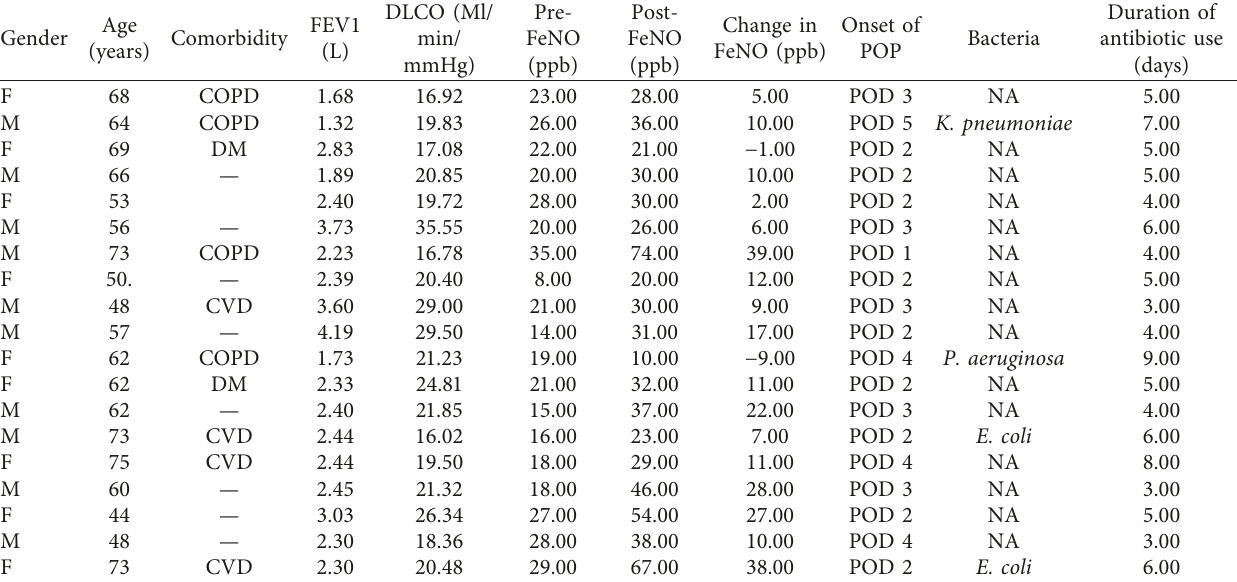
Table 2: Characteristics of patients with POP.